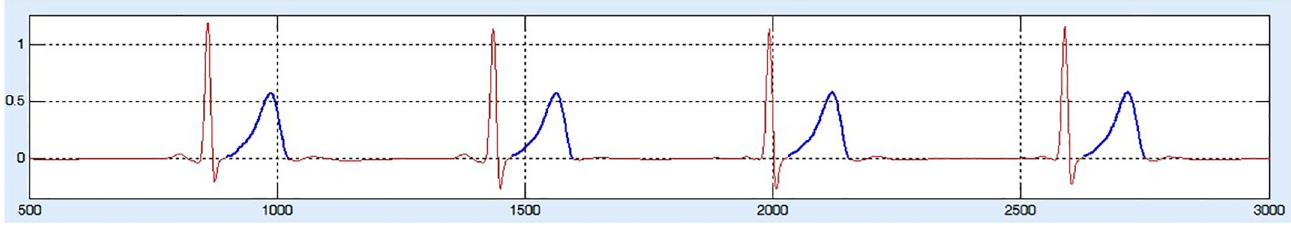
Fig 1. The ST - T segment of ECG used to construct